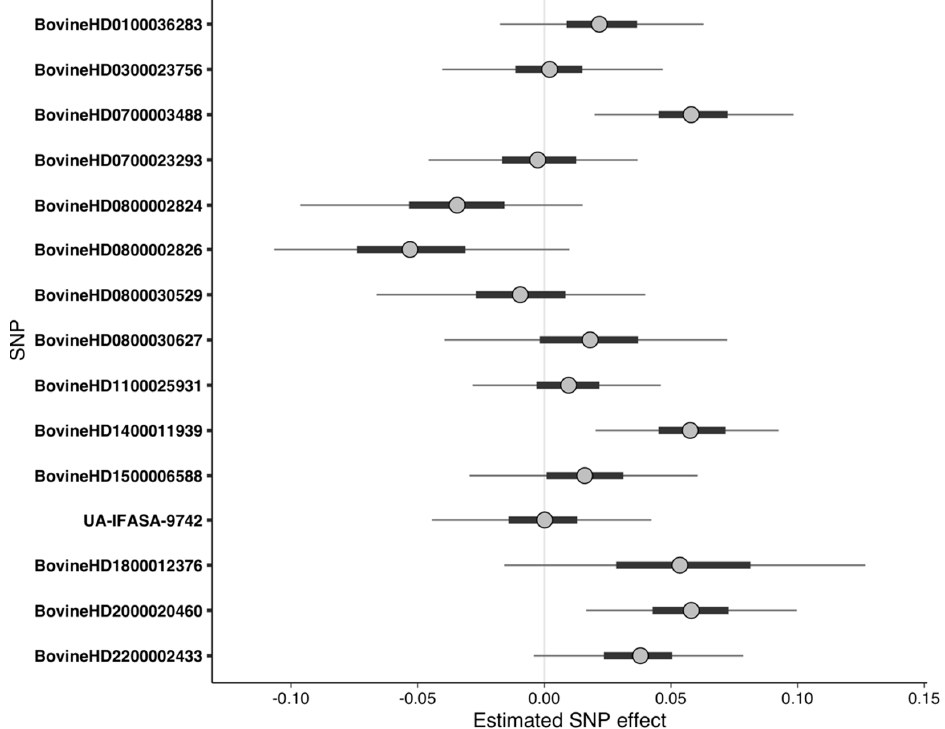
Figure 4. Uncertainty interval (UI) plot for important SNPs from the random forest analysis using quantitative phenotypes. Dots represent the median of the SNP effect estimates from the Markov chain Monte Carlo draws, thick bars indicate the 50% UI, and the thin lines indicate the 95% UI. SNPs with 95% UI not overlapping zero were considered significant. Positive values of the predictor effect estimates indicate a phenotypic value for DD, whereas negative values indicate a phenotypic value for DD.